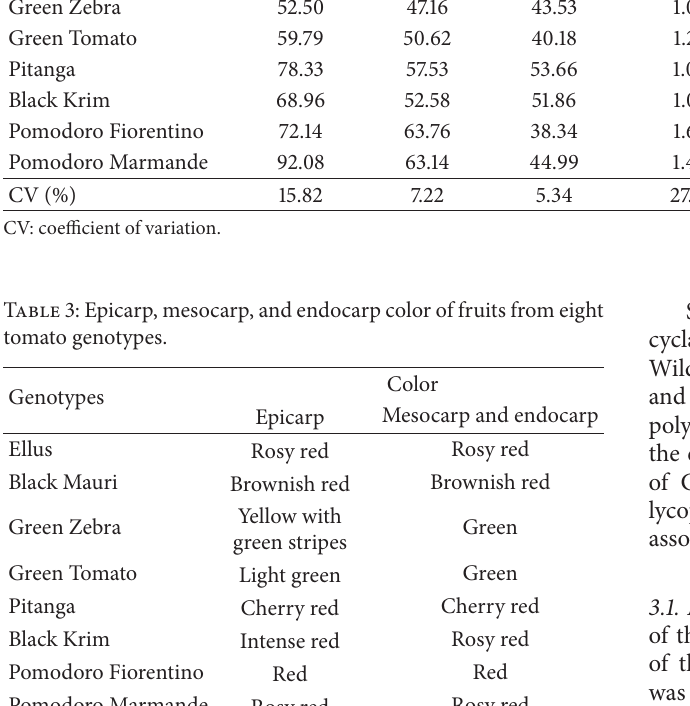
Table 2: Biometrics of tomato fruits, of different genotypes: fresh weight (FW), longitudinal diameter (LD), transverse diameter (TD), longitudinal and transverse diameter ratio (LD/TD), firmness (FIR), mesocarp thickness (THICK), number of locules (LOC), and seed quantity (SEM).